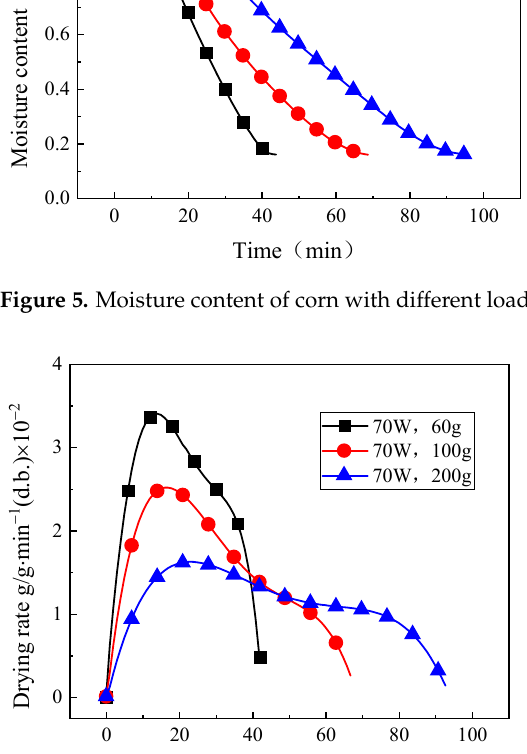
Figure 7. Microwave drying temperature of corn with different loads. 3.3. Comparison between Microwave Drying and Electrothermal Drying of Corn In the same way, 100 g of corn was selected and dried electrothermally at 60, 80, 100, 120, and 140 °C. The moisture content and drying rates of microwave drying and electro ‐ thermal drying are illustrated in Figures 8 and 9. 0